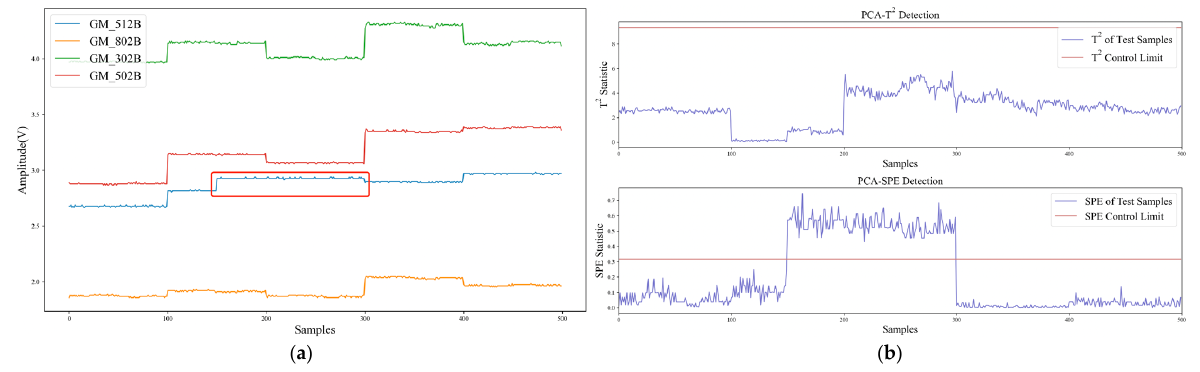
Figure 11. Detection results of persistent fault with PCA model: ( a ) Persistent Fault of Gas Sensor Array; ( b ) Detection Results of PCA-SPE and PCA-T 2 .